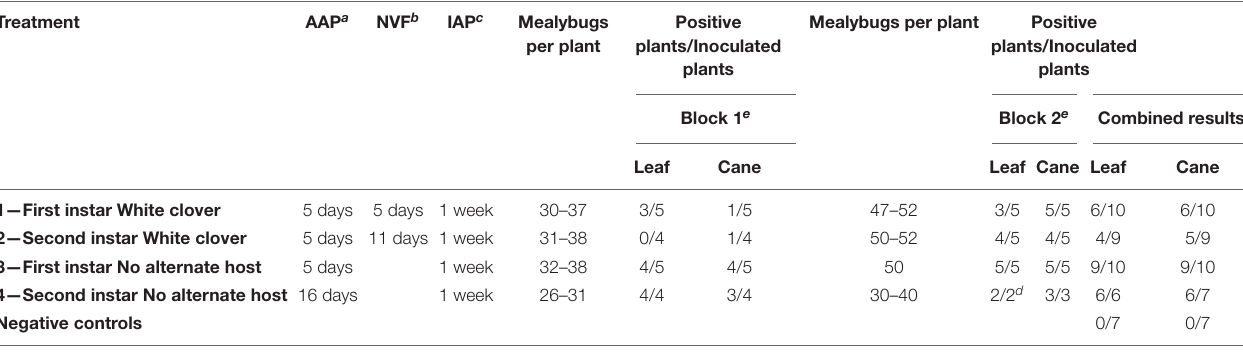
TABLE 2 | Transmission of grapevine leafroll-associated virus 3 (GLRaV-3) by first and second instar Pseudococcus calceolariae initially fed on GLRaV-3-infected grapevine leaves and later transferred to White clover ( Trifolium repens L., a non- Vitis host plant) prior to access to healthy grapevines for transmission of GLRaV-3 (Blocks 1 and